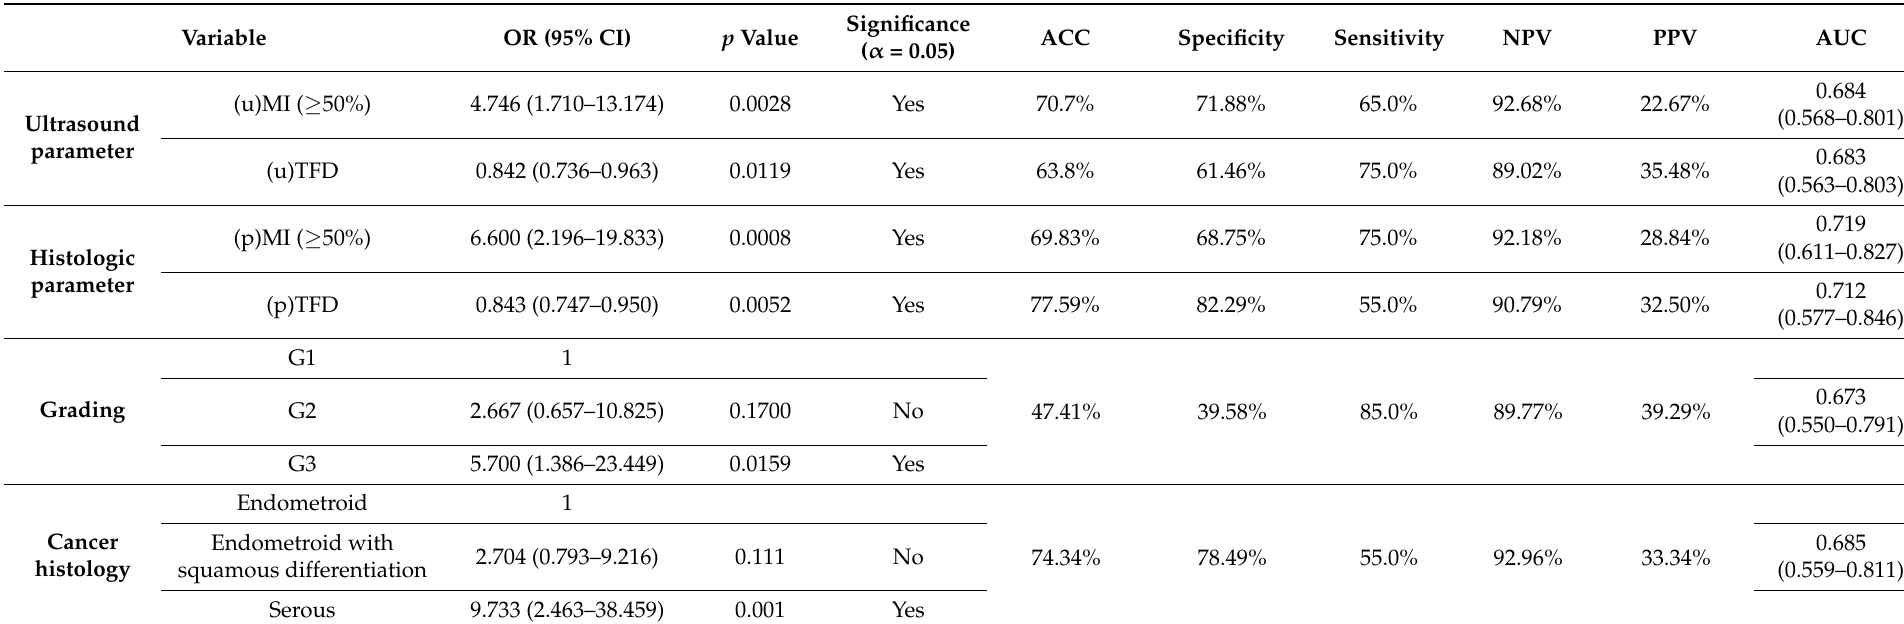
Table 2. Univariable analysis of the value of predictive factors for lymph node metastasis in the study